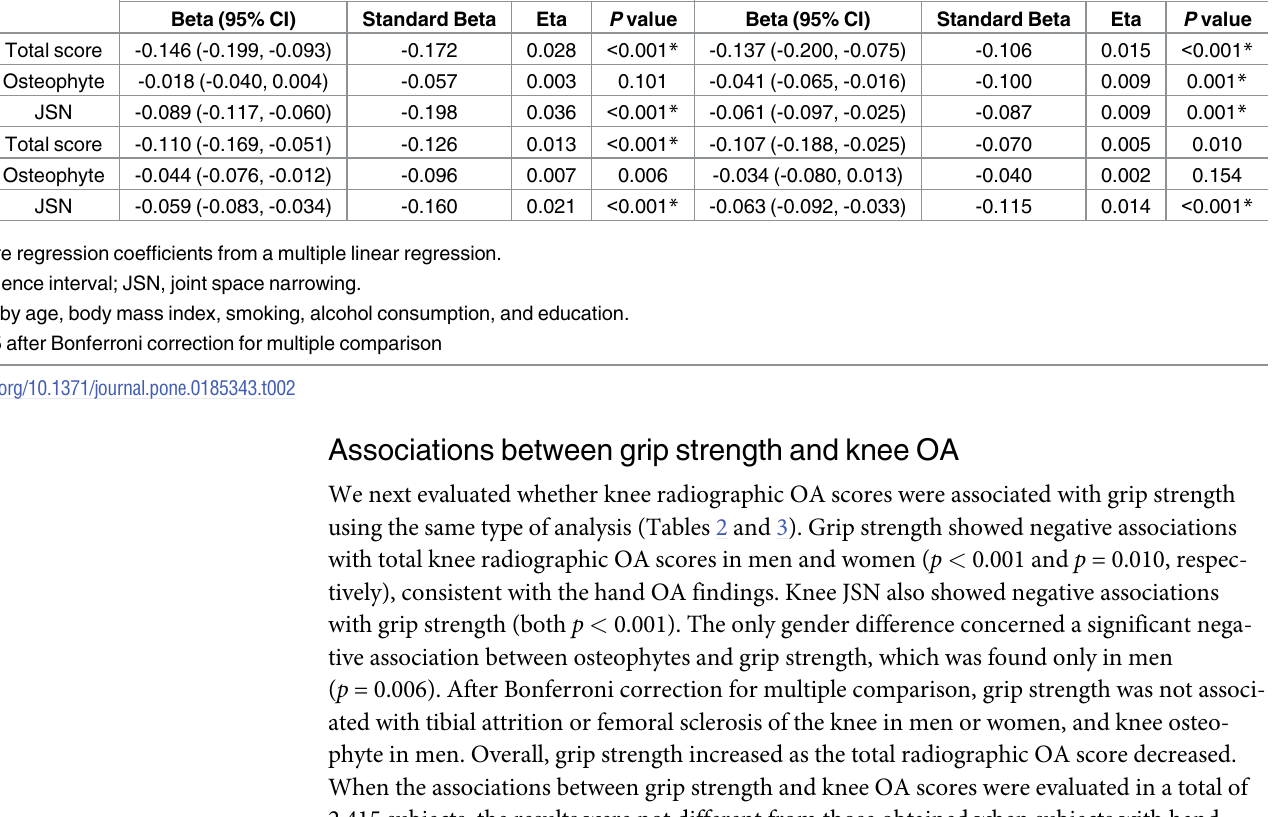
Table 2. Coefficients from a linear regression model examining the association of grip strength (kg) with total and individual radiographic feature scores of hand and knee osteoarthritis.